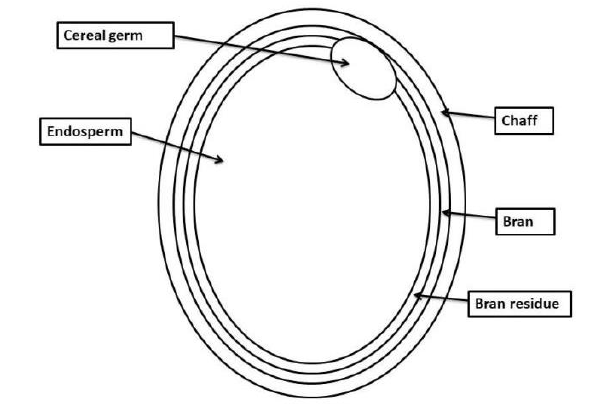
Figure 1. The various parts of the rice grain.